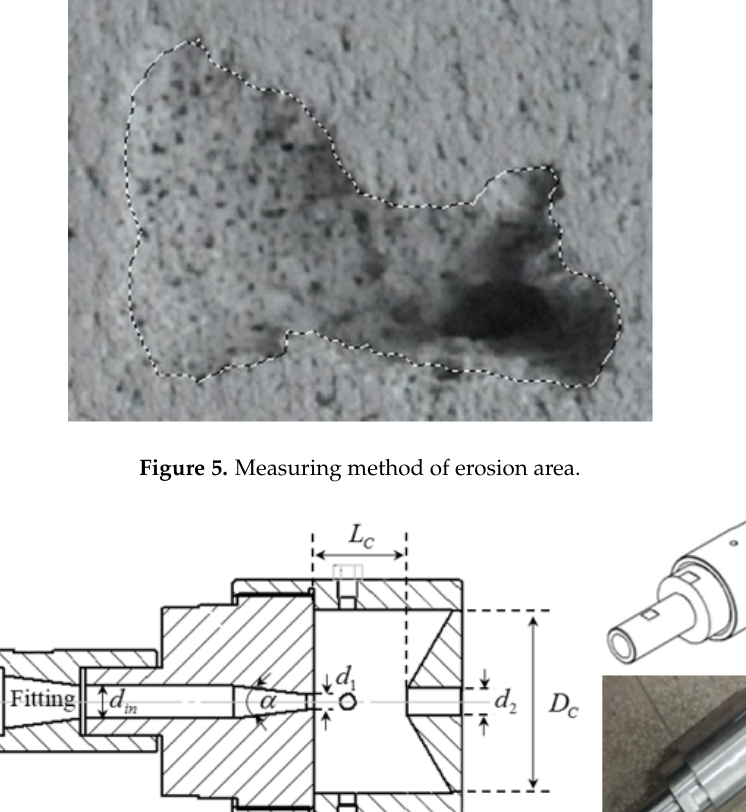
Figure 6. Profiles and photos of the three fittings.